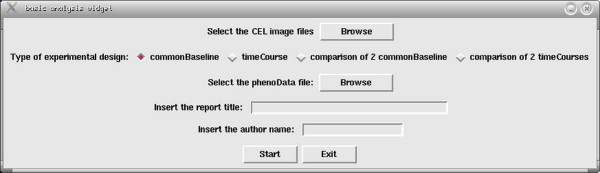
The basic analysis widget. This simple widget allows to run a complete analysis only prompting for few information. The list of CEL files, the type of experimental design and the phenodata file, that is necessary to assign each file to the respective condition, are required. Optionally the name of the report file and of the author can be provided.